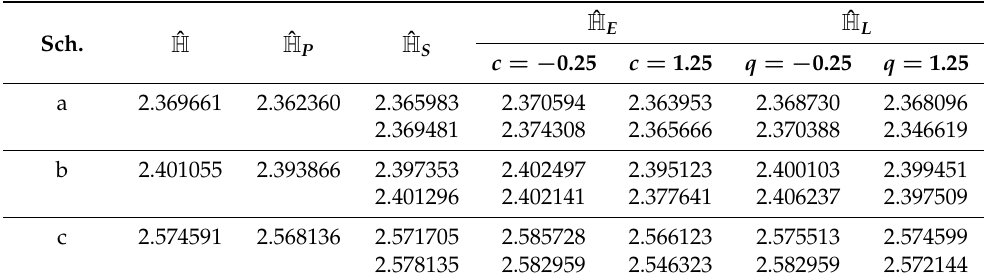
Table 1. Classical and Bayes estimates of entropy for